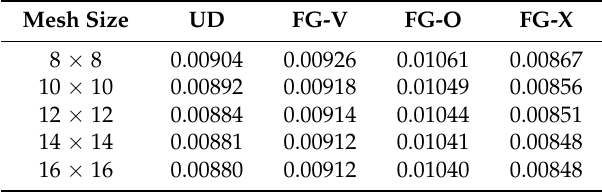
Table 2. Convergence study of the present results for the deflection of a CNT-reinforced plate for clamped boundary conditions.